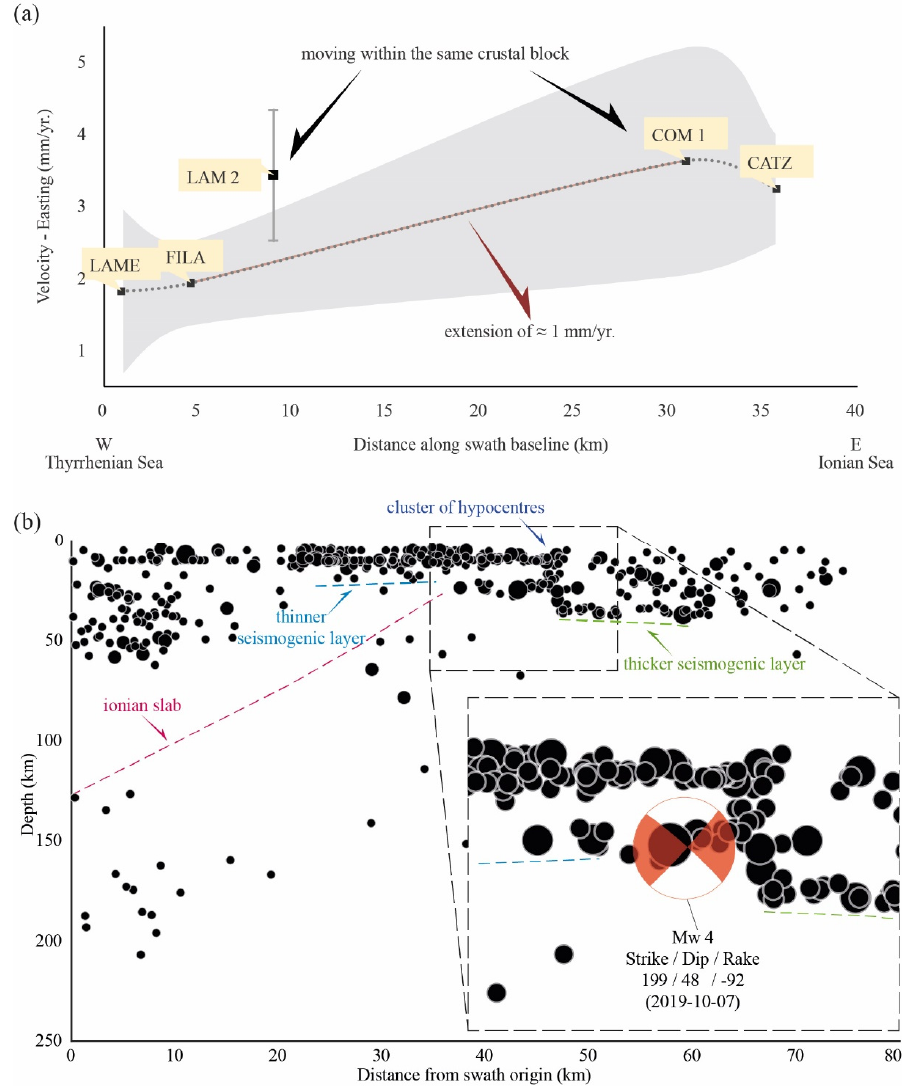
Figure 12. ( a ) GNSS velocity cross-section (data from Pirrotta et al. [9]) along the Catanzaro Trough showing a current extension in the Catanzaro Trough of about 1 mm/year (section trace is plotted in Figure 11). ( b ) Swath cross-section showing the earthquake hypocentre distribution (data from http://terremoti.ingv.it/, accessed on 15 July 2022, see also [54]) in the Catanzaro Trough (section trace is plotted in Figure 11). The beachball refers to the 2019 Mw 4 earthquake (see Figures 1 and 11 for location).